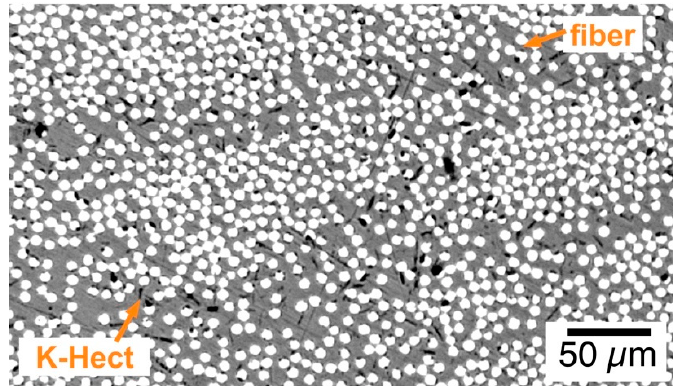
Figure 12. Microscopic picture of a cross-section of laminate with 0.6 vol % K-Hect. White: fibers; black: layered silicates; grey: epoxy matrix.